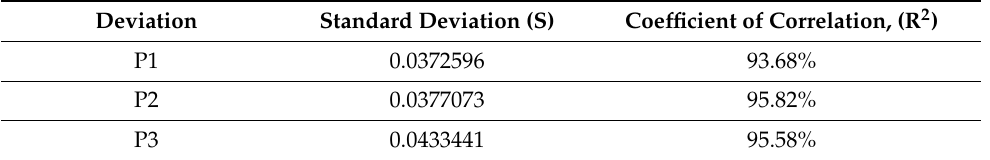
Table 5. Statistical parameters from the regression analysis, adapted with permission from ref. [5].